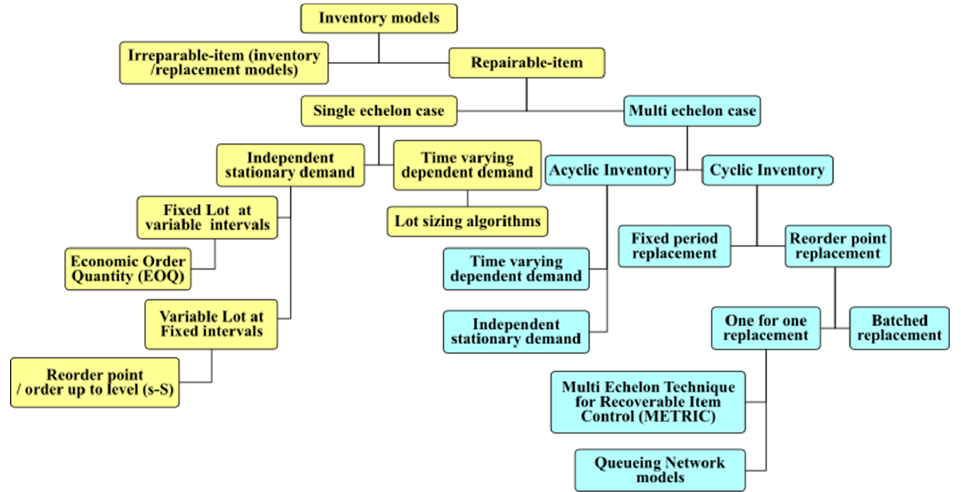
Figure 5. Inventory models. “Source [16,49–53,56–61], own elaboration.”.